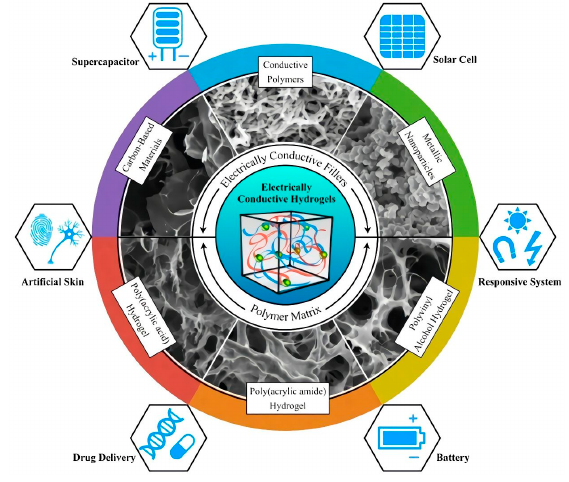
Figure 7. Electrically conductive hydrogels are an emerging class of hydrogels combining a hydrophilic matrix with conductive fillers, and they have exceptional promise in a wide range of applications. Reprinted with permission from Ref. [116].